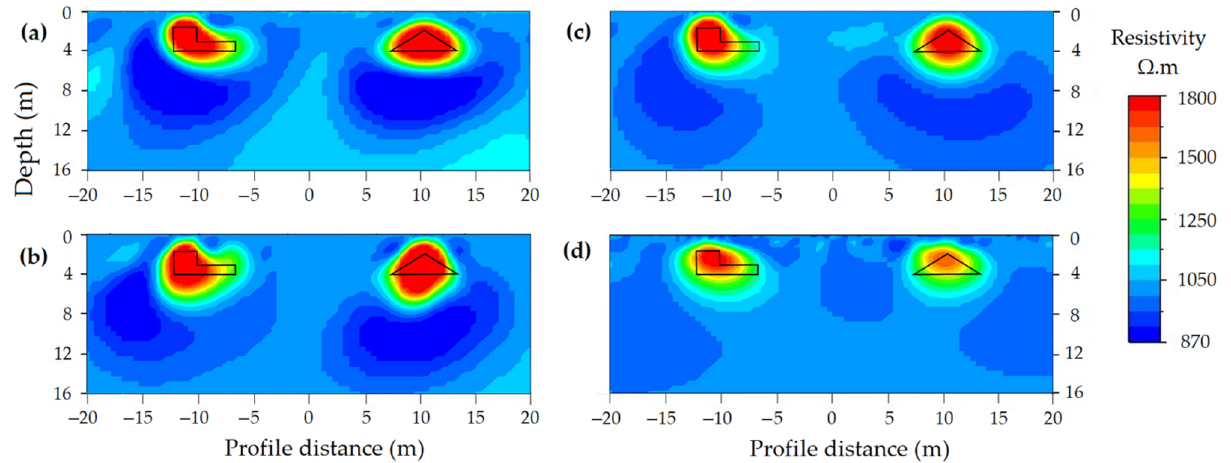
Figure 17. The inverted resistivity model for the vertical (90°) cavity size using: ( a ) DD array, ( b ) PD array, ( c ) WS array, ( d ) PP array. The rectangular box indicates the actual cavity target.